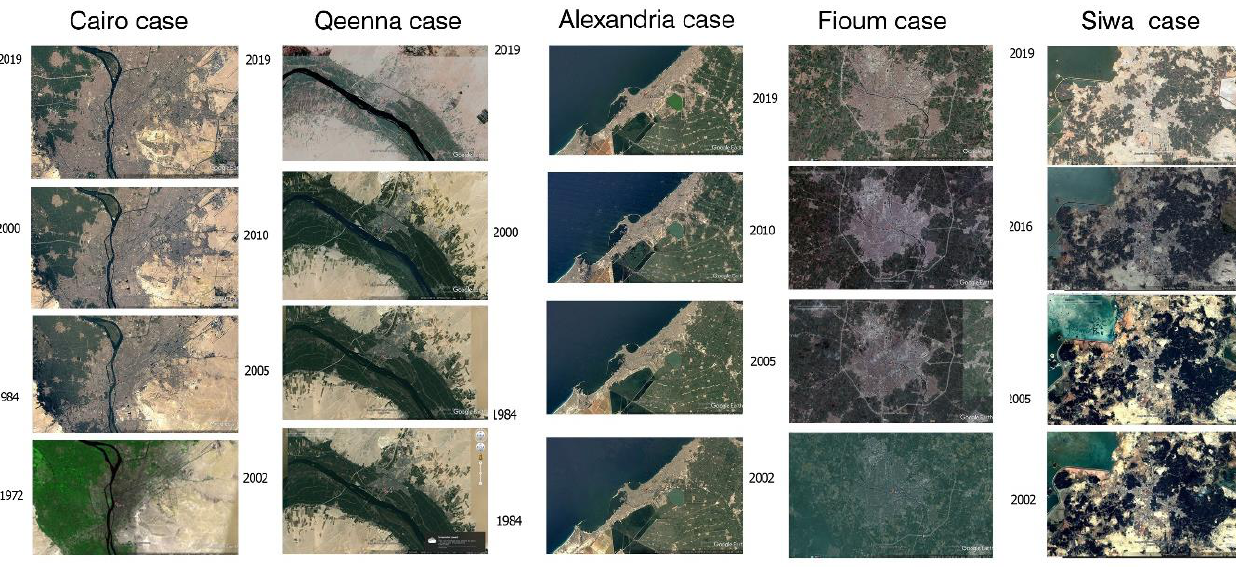
Figure 4: Illustration of the case of urbanization in Egypt from 1972 to 2019 Source: Google maps extracted by